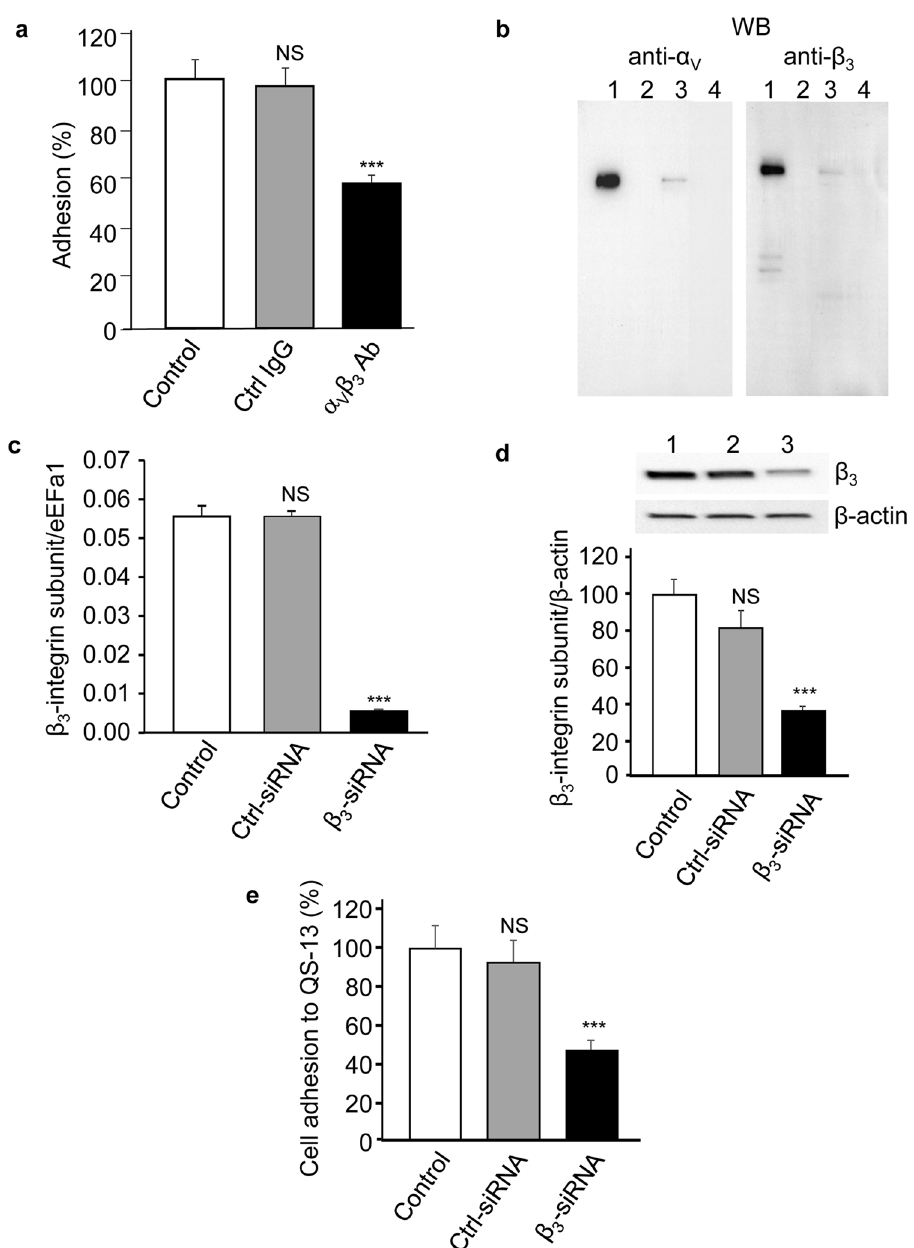
Figure 2. QS-13 peptide binds to SK-MEL-28 through α v β 3 integrin. Cells were pre-incubated for 30 min with an anti- α v β 3 blocking antibody or an irrelevant IgG (10 µ g/mL) before seeding on QS-13 peptide and adhesion was assessed ( a ). Cell extracts were submitted to affinity chromatography on a QS-13 peptide-bounded column and analyzed by western blot. Total cell extract (line 1), fraction eluted with 0.15 M (line 2), 0.6 M (line 3), 1 M NaCl (line 4) ( b ). Cells were transfected with β 3 subunit siRNA or control siRNA. Gene expression was measured by RT-qPCR 24 h after transfection ( c ). Protein expression was assessed by western-blot 48 h after transfection. Lane 1: control; lane 2: control siRNA; lane 3: β 3 subunit siRNA ( d ). Cells were seeded on QS-13 peptide 48 h after transfection and adhesion was measured ( e ) *** p <